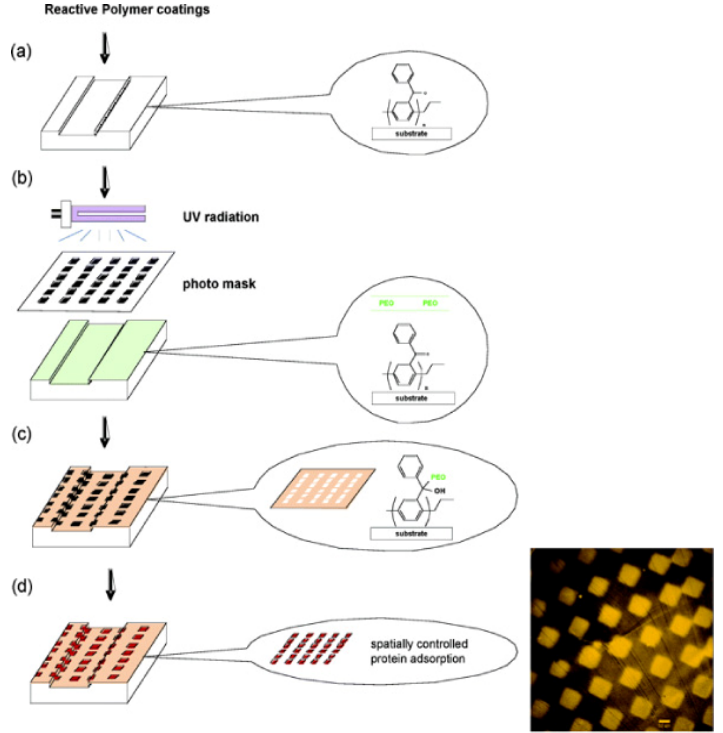
Figure 14. Spatially controlled protein adsorption via photopatterning of reactive coatings deposited within microchannels. (a) Reactive coatings are deposited via